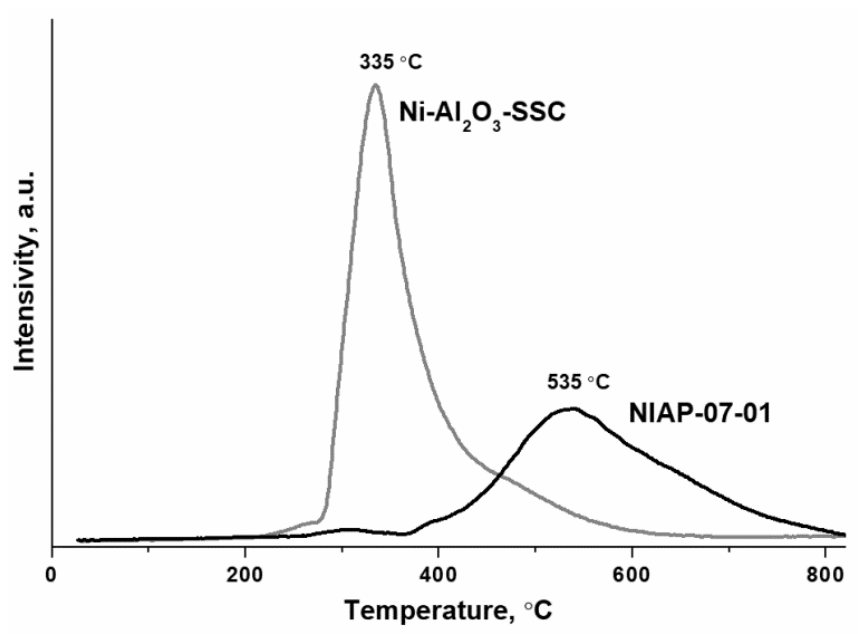
Figure 10. H 2 -TPR profiles of NIAP-07-01 and Ni-Al 2 O 3 -SSC catalysts. Ni-Al 2 O 3 -SSC catalyst consumes more hydrogen compared to NIAP-07-01. This